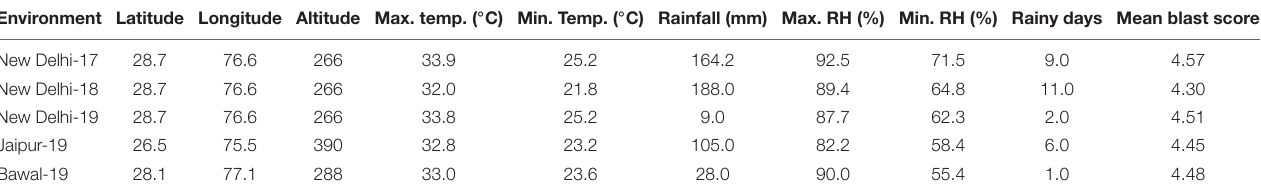
TABLE 1 | Geographical identity and climate variables at test environment in respect of temperature, relative humidity (RH), total rainfall, and rainy days along with mean foliar blast (FB) score during the critical period of pearl millet crop growth.